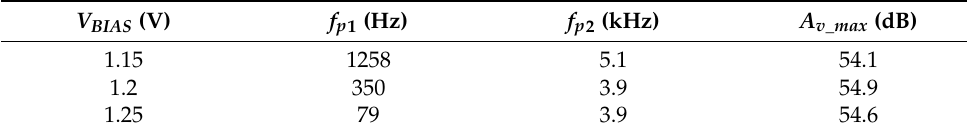
Table 3. Active BPF measured characteristics.